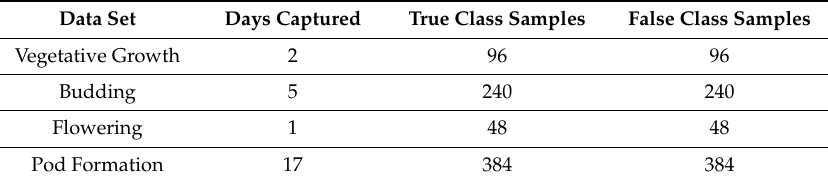
Table 1. Growth stage binary classification data used in this study and the corresponding number of samples in a one-vs.-rest fashion: True class samples indicate the number of samples that were labeled as the “true” class (e.g., vegetative growth) or of the “false” class (non-vegetative growth; i.e., rest). Numbers below indicate the number of samples for each